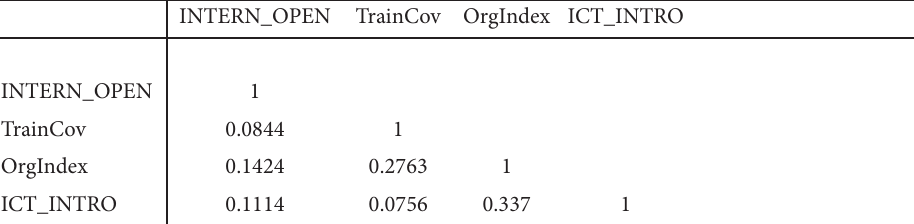
Table A3. Correlations for non-binary